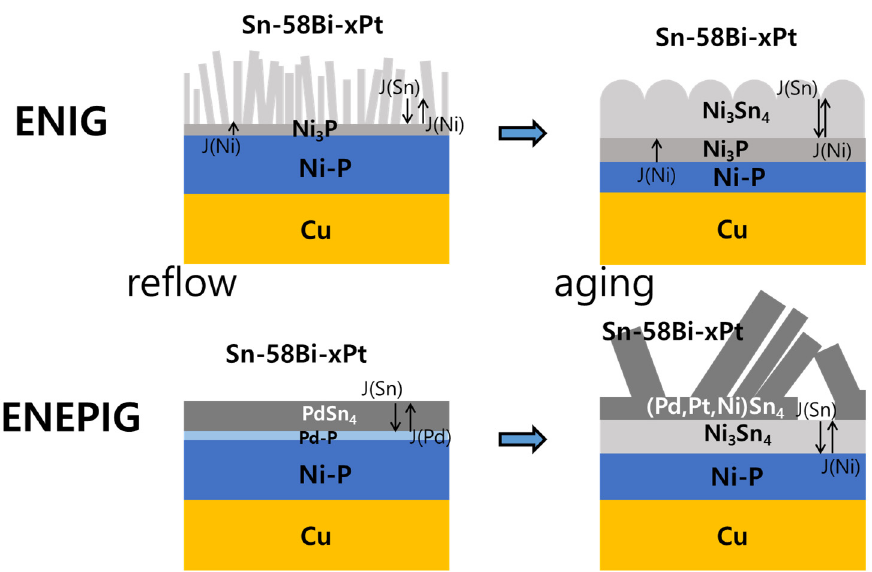
Figure 10. Comparative schematic model of the interfacial microstructures after reflow and after aging with the possible fluxes due to interdiffusion in the ENIG/ and ENEPIG/Sn-58Bi-xPt solder joints. The different components are not to scale.